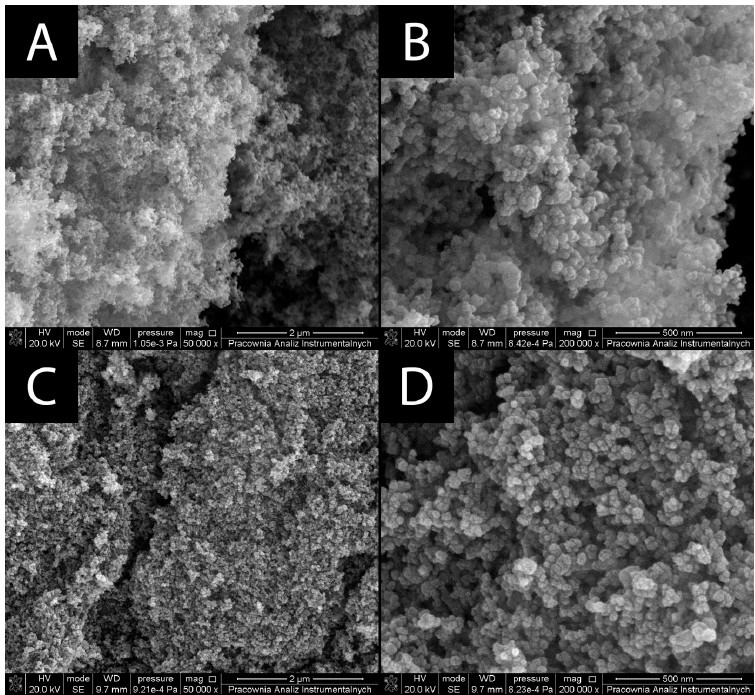
Figure 1. SEM images of prepared nanomaterials. ( A , B ) TiO 2 , ( C , D ) TiO 2 -GA.